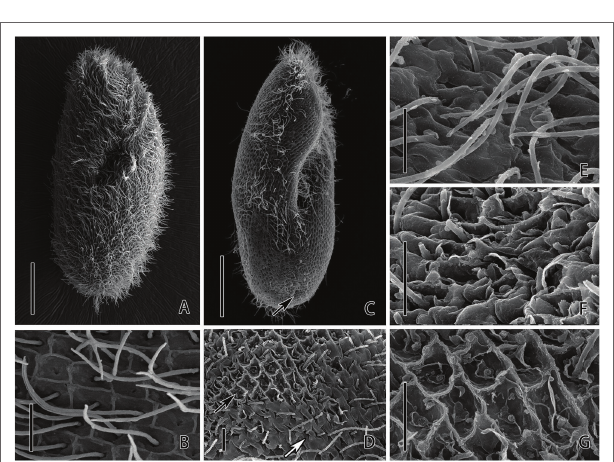
FIGURE 2 | Scanning electron microscopic observation of P. bursaria under control (A,B) and CuNPs treatment (C–G) . (A) The cell of P. bursaria under control. (B) The grids on the surface of P. bursaria and a cilium stretch out from the pellicle on the center of the grid. (C) The cell of P. bursaria under CuNP treatment. The arrow denotes the sunken posterior end. (D) The damage on the cortical surface of the cell. The black arrow and white arrow showing the different degrees of damage on the cell. (E,F) Three different degrees of surface damage, from slight to severe. Scale bars = 20 μ m (A,C) and 2 μ m (B,D–G)